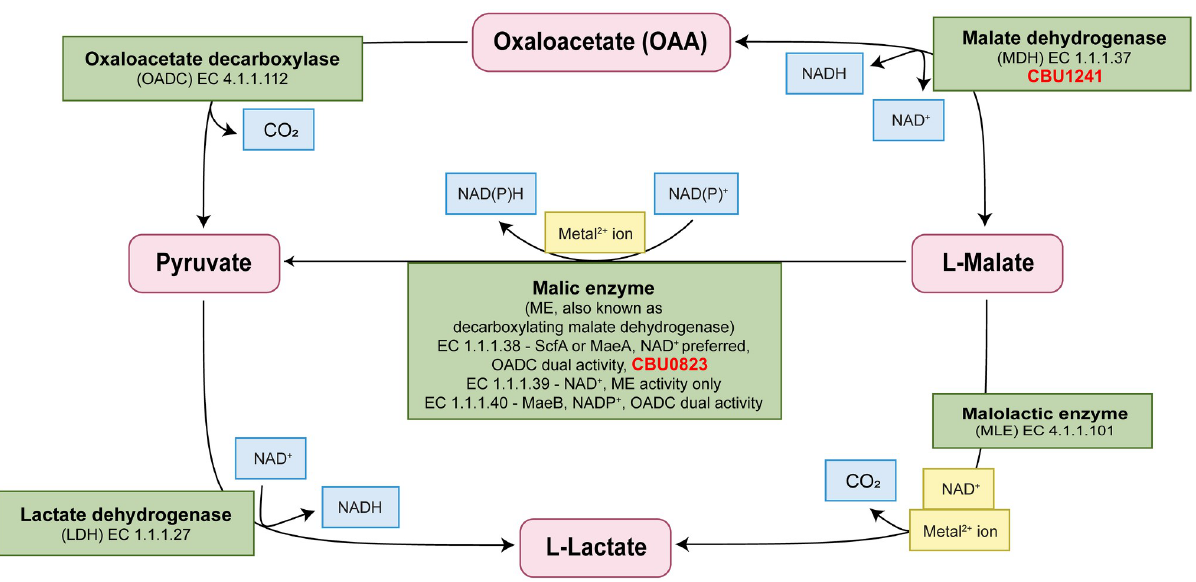
Fig 1. Schematic representation of enzymes commonly involved in 2-keto acid metabolism and their corresponding reactions. The enzymes, shown in green boxes, may require cofactors, shown in gold boxes. Additional substrates and products are shown in blue boxes. CBU0823 and CBU1241 have been included with their respective putative annotations. Adapted from